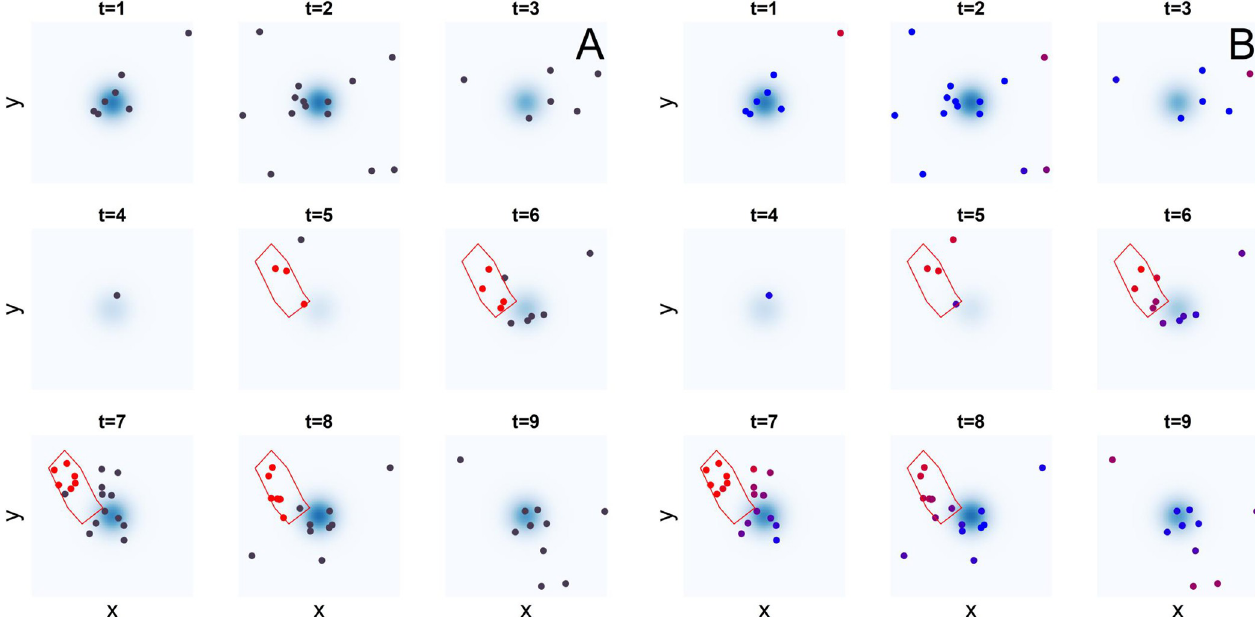
Fig 2. Simulation experiment. A Synthetic baseline point events (black markers) for 1 � t � 9. Additional points representing an outbreak (red markers) are in the areas delimited in red. B Algorithm prediction. Episode markers are coloured by their warning scores, blue (w = 0) to red (w = 1). The algorithm assigns high warning scores to the events in the outbreak areas.